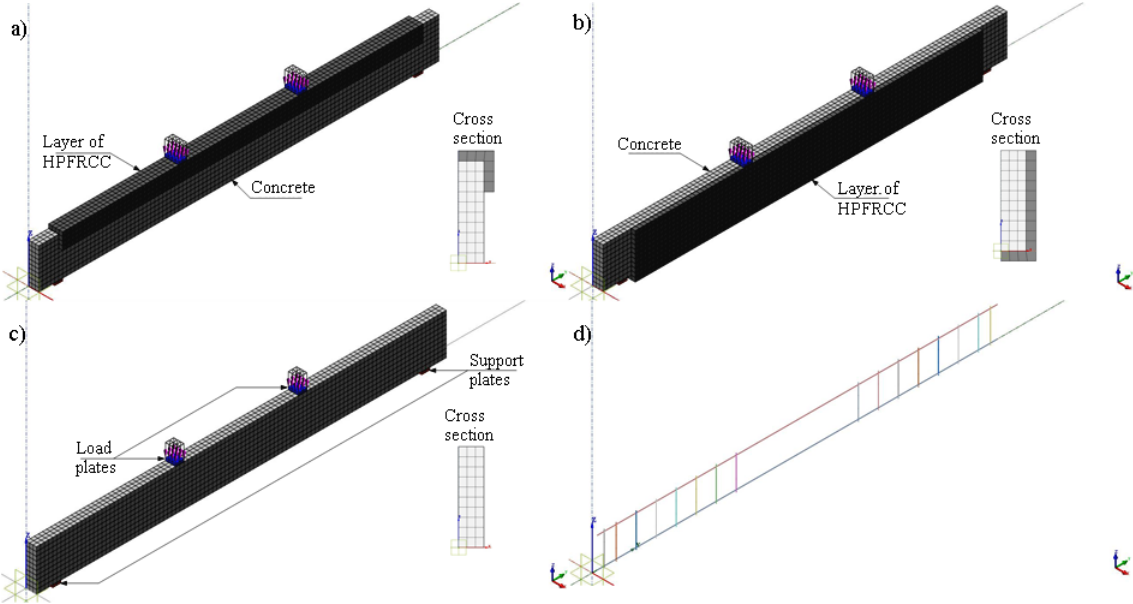
Fig. 7. Finite element models of the beams: (a) model of the SxT beams, (b) model of the SxU beams, (c) model of the Sx beams, (d) model of the reinforcement